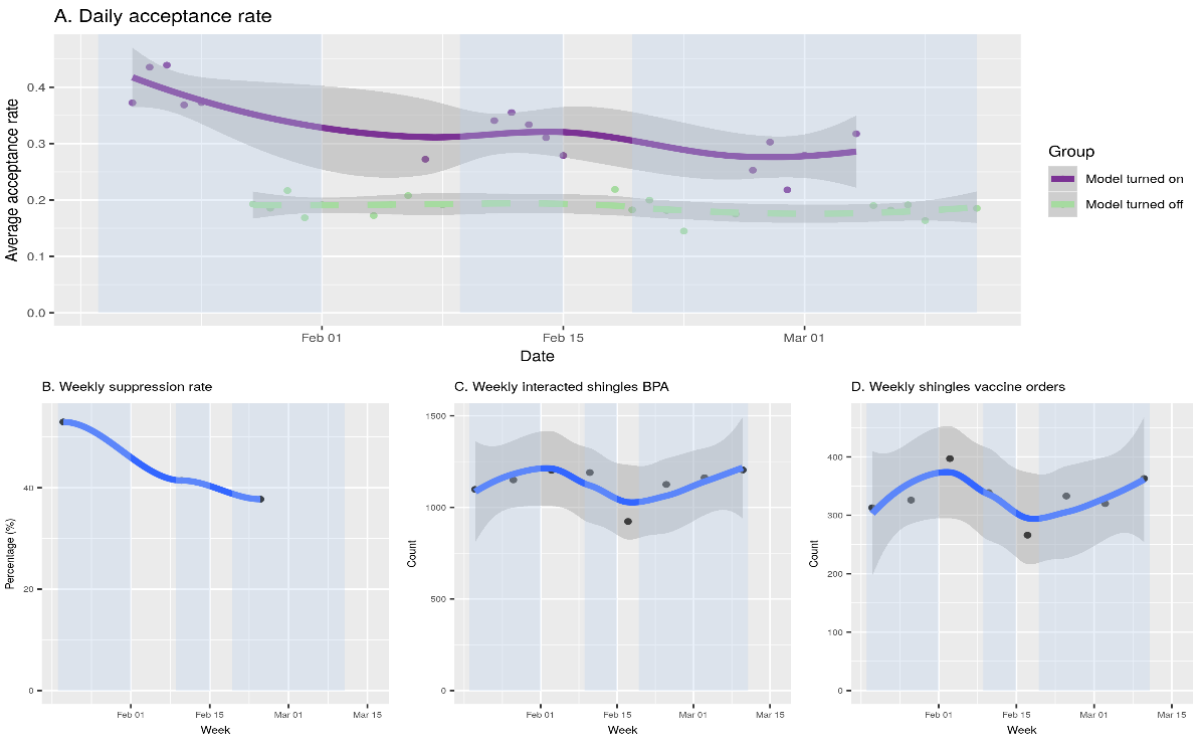
Figure 4. Summary reports of the shingles model from January 19, 2019, to March 11, 2019. (A) Smoothed curves of daily aggregated acceptance (response) rates to the shingles best practice advisory (BPA; alert), 95% CI shown in shaded areas, respectively (model turned on is shown in the purple solid curve and model turned off is shown in the light green dotted curve). Weekends are not included because of the large variation resulting from low BPA volumes on weekends. Vertical shaded areas annotate the 6-week trial time period. (B) Weekly averaged suppression percentage of the shingles alert. (C) Weekly count of interacted shingles BPA. (D) Smoothed curve of weekly shingles vaccine order